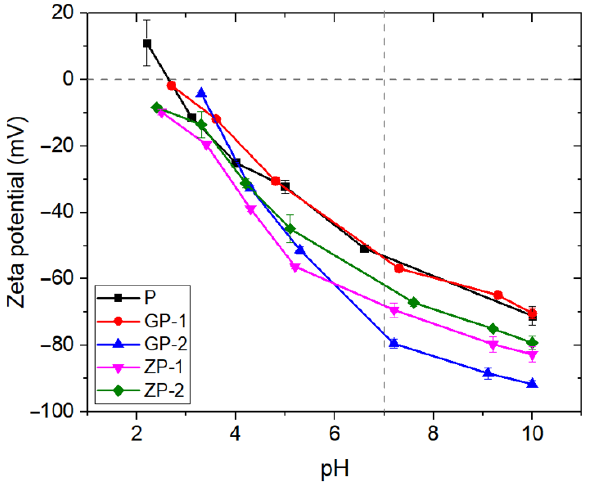
Figure 10. The surface zeta potential of fabricated membranes.